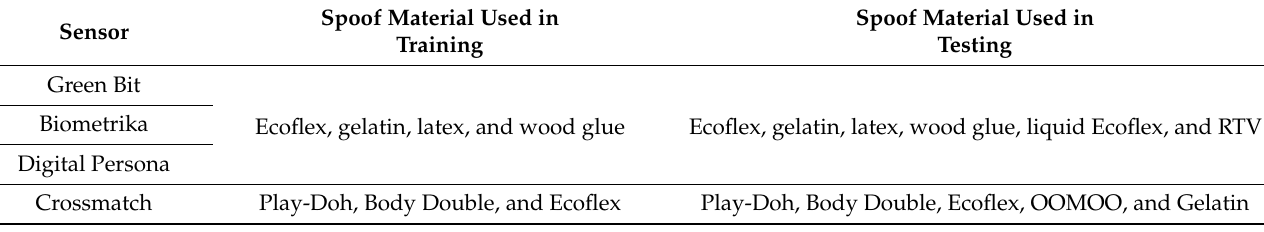
Figure 5. Sample images of LivDet2015 dataset. Live samples are in the top row and fake samples are in the bottom row. Samples are from Digital Persona ( a ), Green Bit ( b ), Biometrika ( c ), and CrossMatch ( d ) sensors. Table 2. Spoof materials used in LivDet2015